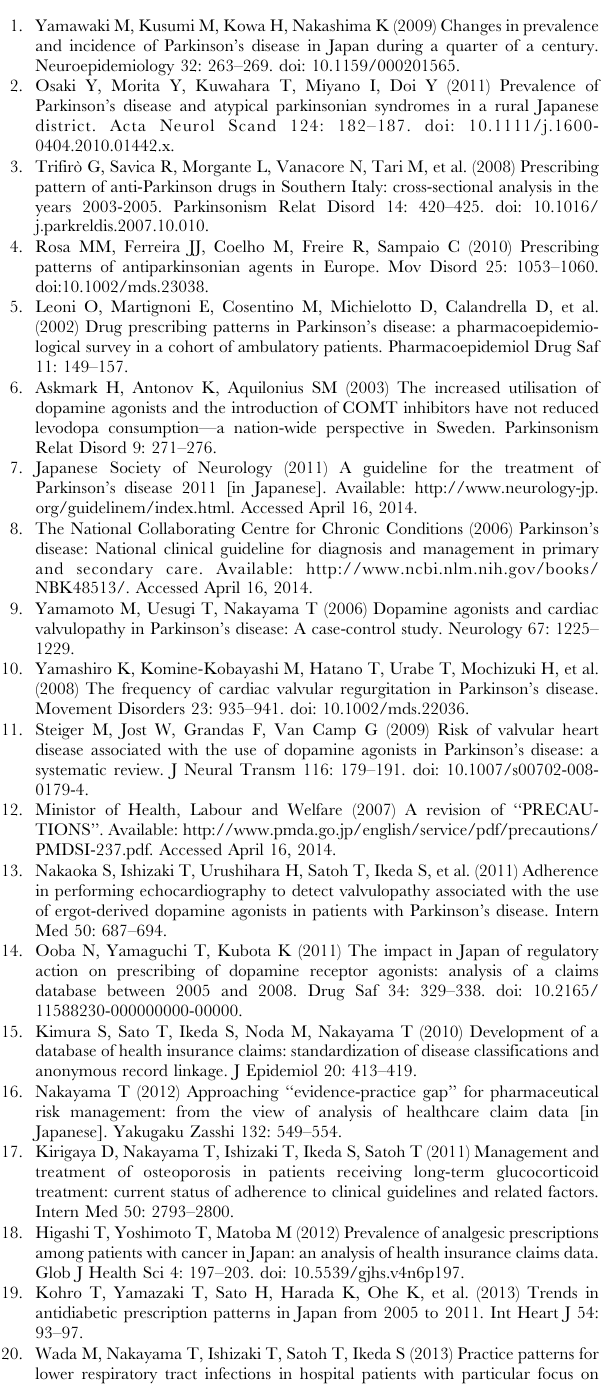
Table S2 Proportions of Patients in Two Age Groups Who Were Prescribed First-line Drugs Before and After Cabergoline and Pergolide Product Label Revisions for Valvulopathy